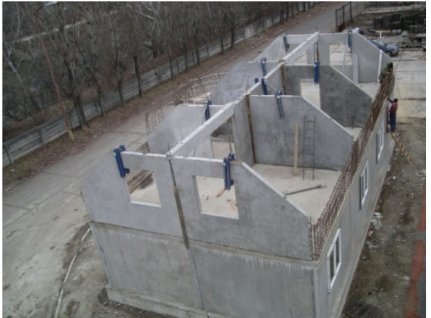
Figure 22. Mounting the attic (Photo archive: Kal ú s, D.) [13].